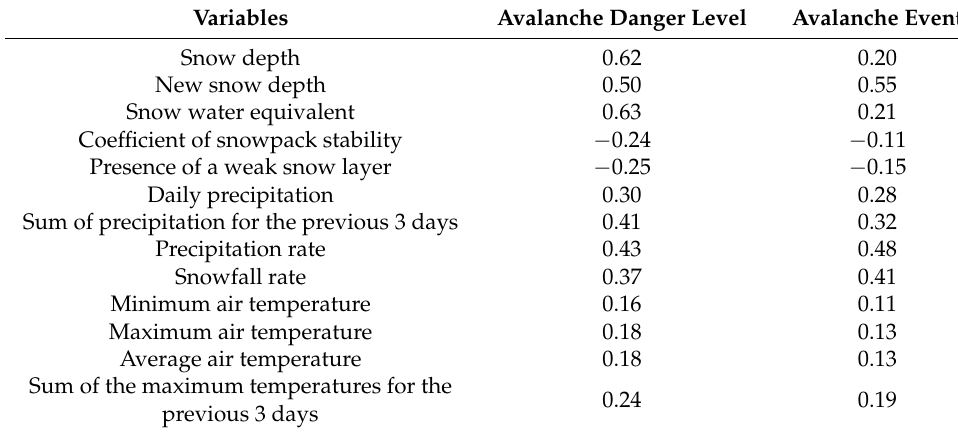
Table 3. The Spearman’s correlation coefficients of variables with the avalanche danger level and the avalanche